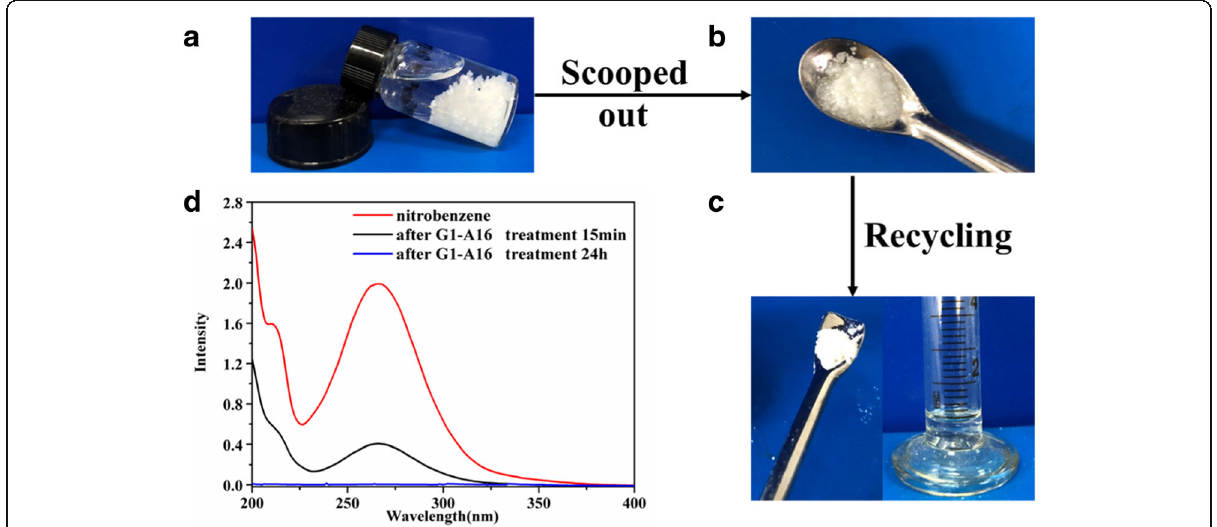
Fig. 3 a Specific gelation of the nitrobenzene phase using G1-A16 ( G1-A16 is 40mg) as a phase selection gel in a two-phase mixture of nitrobenzene and wastewater (1mL/3.0mL, NaNO 3 and Na 2 SO 4 concentration of wastewater is 0.5M respectively) by mechanical shaking. b Separation of the formed gel – water mixture into the nitrobenzene gel via simple scooping out. c Recovery of nitrobenzene from the G1-A16 nitrobenzene gel via distillation, and purification of the restored gelator by recrystallization. d UV – vis spectra of the nitrobenzene before and after removal over the